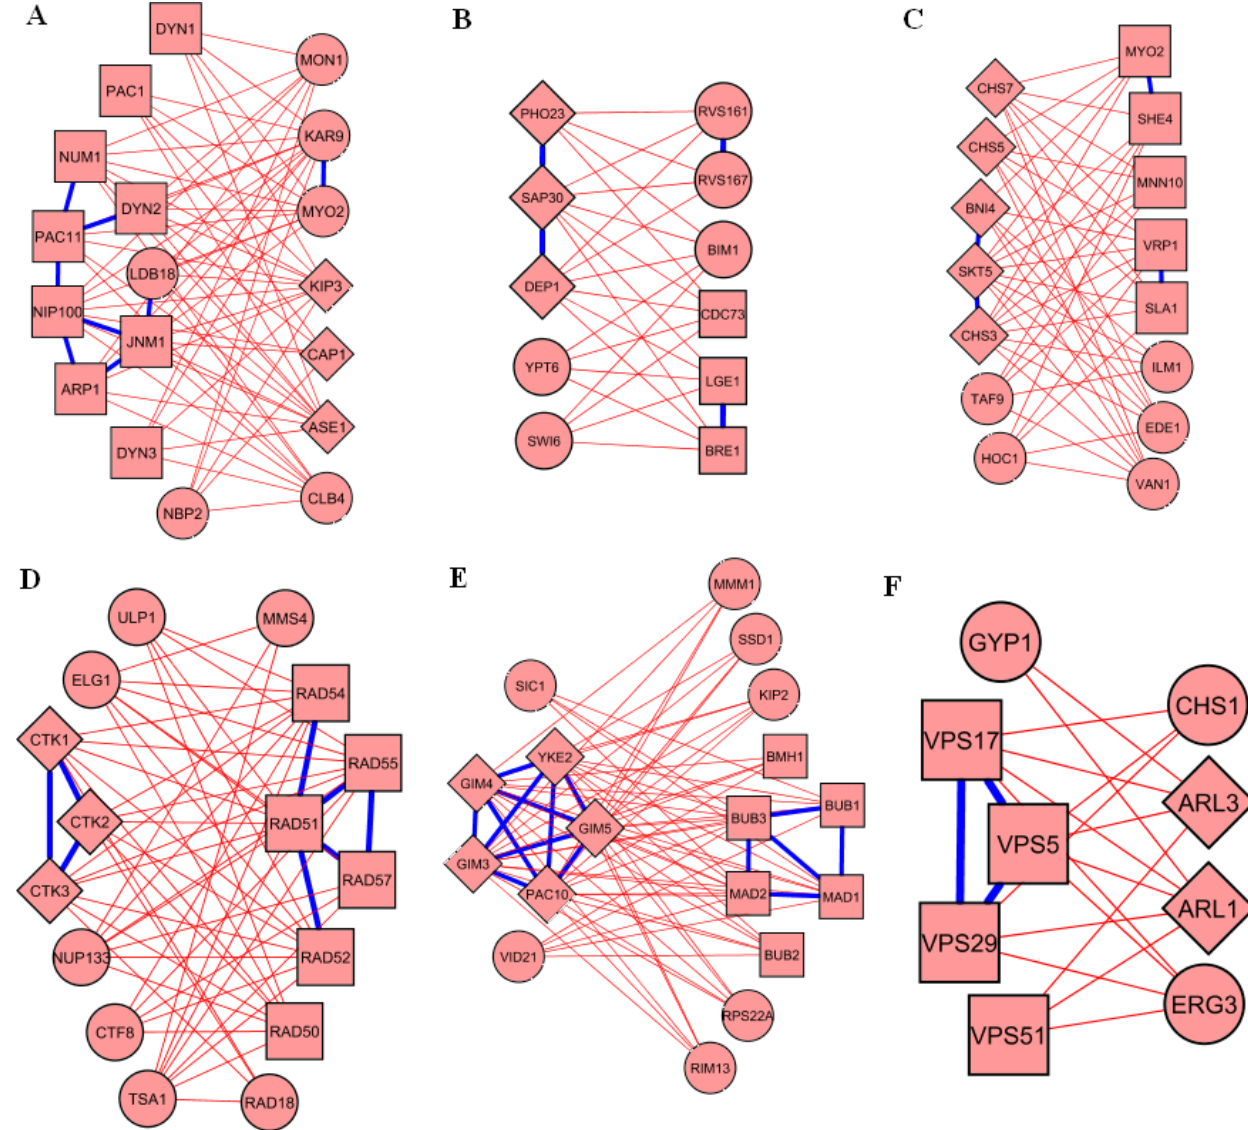
Figure 2. Example pathway pairs identified by our method. Each example is shown in a pair: left: pathway 1, right: pathway 2. Heavy blue lines represent physical interactions (protein-protein interaction and/or protein-DNA interactions) between genes and red lines represent synthetic lethal interactions. Diamonds and Boxes represent genes with the dominant function for pathway 1 and pathway 2, respectively (see text for details). (A) The dynein-dynactin pathway and protein depolymerization. (B) Histone deacetylation and histone methylation. (C) Actin filament-based process and chitin metabolic process. (D) Positive regulation of RNA elongation and double-strand break repair via single-strand annealing. (E) Tubulin folding and spindle checkpoint. (F) Golgi to plasma membrane protein transport and retrograde transport, endosome to Golgi.